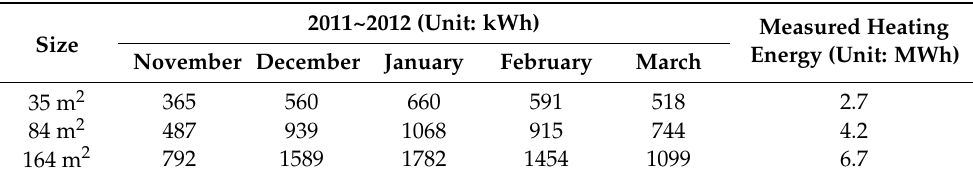
Table 5. Measured annual heating energy consumption according to the growth in household size in 2011.